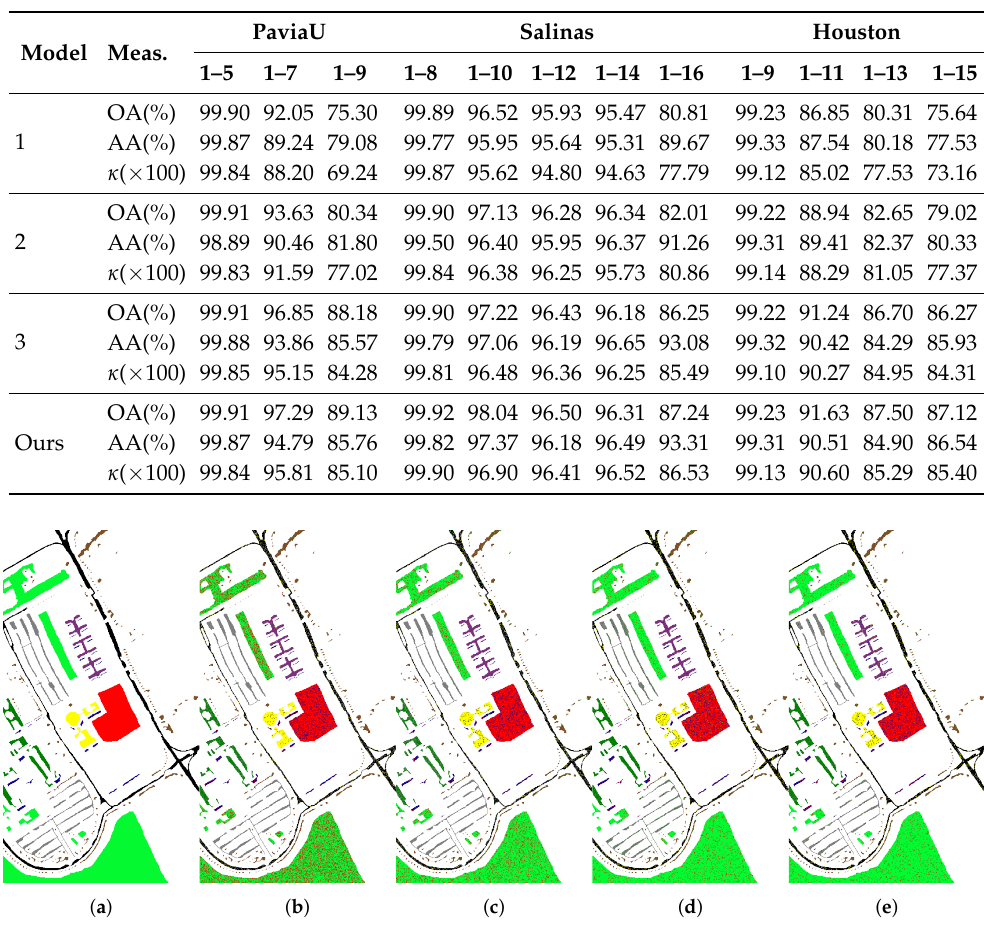
Figure 9. PaviaU. Classification maps of different models. ( a ) Pseudocolor images; ( b ) Model-1; ( c ) Model-2; ( d ) Model-3; ( e )